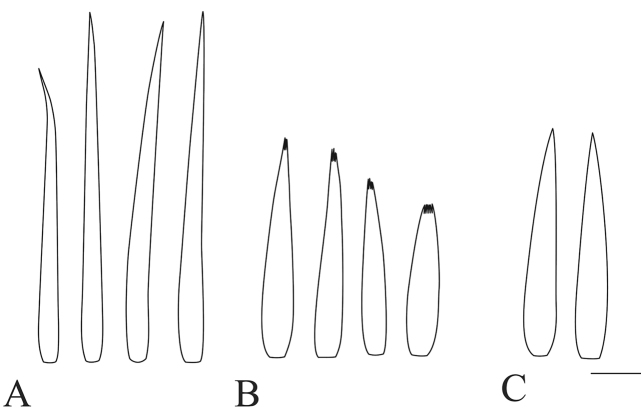
Forefemur transverse row of setae. ADudgeodes
bauernfeindi sp. nov. BD.
pangantihoni sp. nov. CD.
tabang sp. nov. Scale bar: 20 μm.